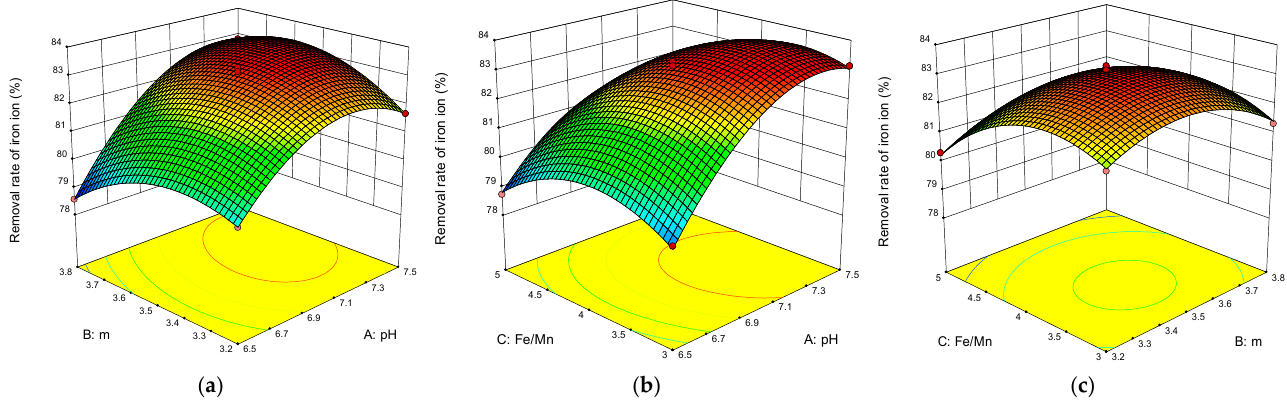
Figure 7. The 3D response surface diagram of manganese sand dosage and pH ( a ), initial concen- tration ratio of Fe/Mn and pH ( b ), initial concentration ratio of Fe/Mn and manganese sand dosage ( c ) influence iron ion removal.